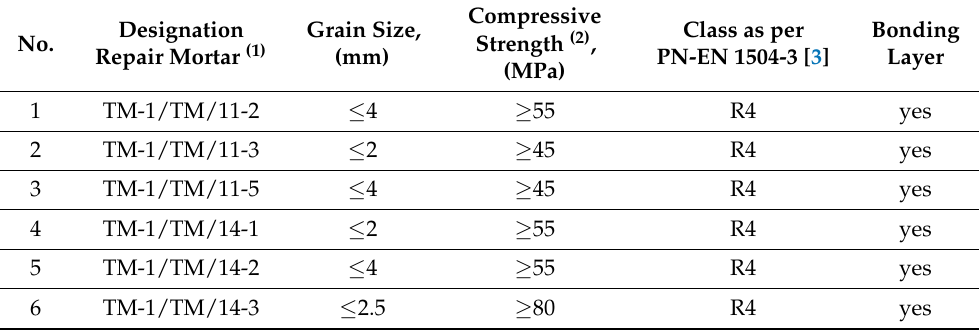
Table 1. Summary of repair mortars subjected to comparative